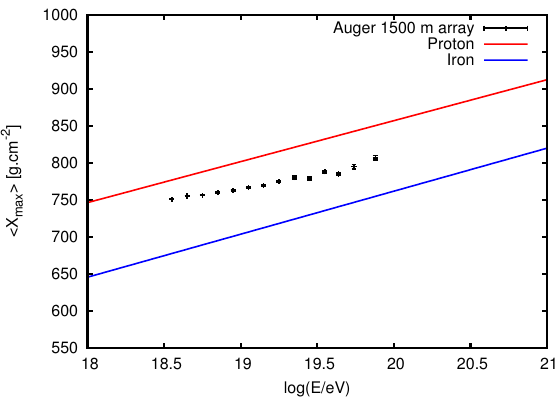
Figure 6. Distribution of the depth of shower maximum X max obtained by our simulation compared to the experimantal data measured by the 1500 m Array of the PAO [12].